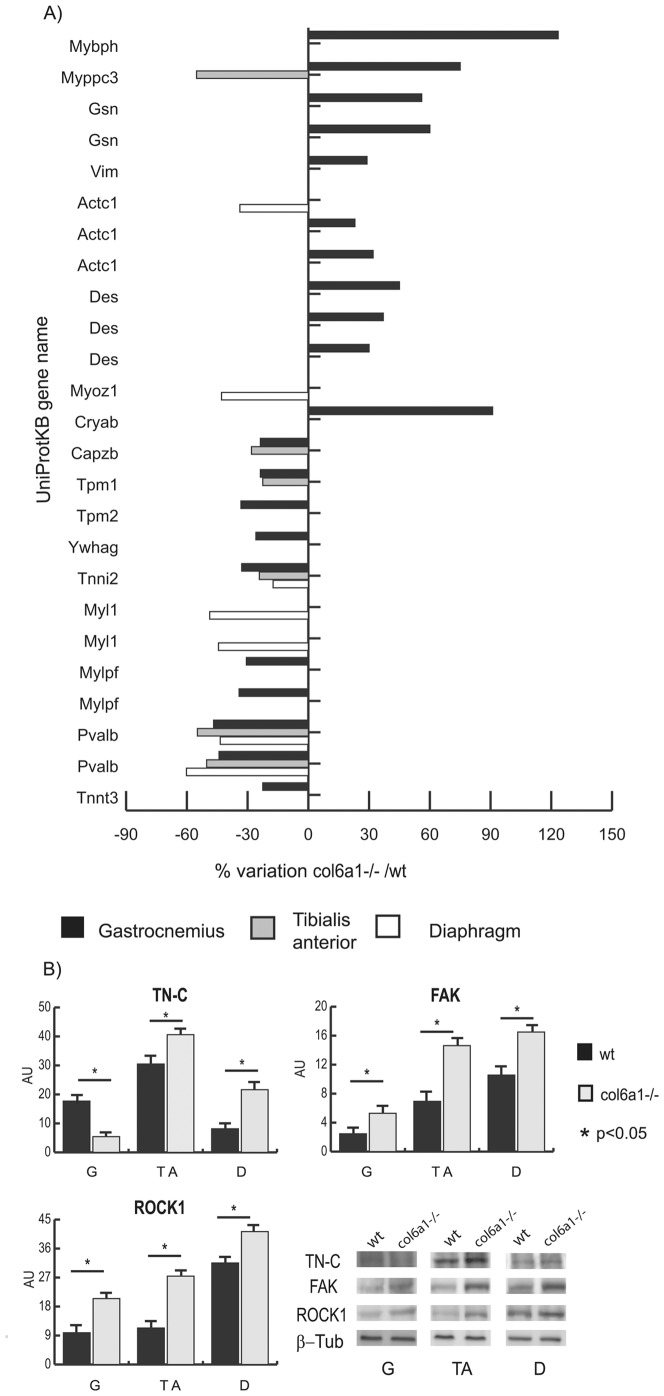
Histograms of proteomic results and Immunoblotting of cytoskeletal proteins.Panel A: histograms of structural and cytoskeletal proteins differentially expressed in gastrocnemius (black bars), tibialis anterior (grey bars) and diaphragm (white bars) muscles. Proteins significantly altered (Student’s t-test, p<0.01) are expressed as % of spot volume variation in Col6a1
−/− versus wild-type. (Mybph: myosin binding protein H, Mybpc3: myosin binding protein c; Gsn: gelsolin; Vim: vimentin; Actc1: actin, alpha cardiac muscle 1; Des: desmin; Myoz1: myozenin1; Cryab: alpha-crystallin B chain; Capzb: capping protein (actin filament) muscle Z-line, beta isoform; Tpm1: tropomyosin 1 alpha chain; Tpm2: tropomyosin 2 beta chain; Ywhag: 14-3-3 protein gamma; Tnni2: troponin I, fast skeletal muscle; Myl1: myosin A1 catalytic light chain; Mylpf: myosin light chain, phosphorylatable, fast skeletal muscle; Pvalb: parvalbumin; Tnnt3: troponin T, fast skeletal muscle). Panel B: histograms and representative immunoblot images of TN-C, FAK and ROCK1 in gastrocnemius, tibialis anterior and diaphragm of Col6a1
−/− and wild-type mice (n = 4; mean ± S.D.; Student’s T-test).